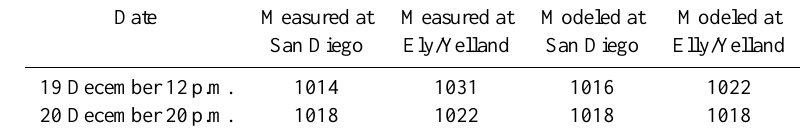
Table 3. Measured and modeled pressure (HPa) at San Diego Airport and Ely/Yelland field station